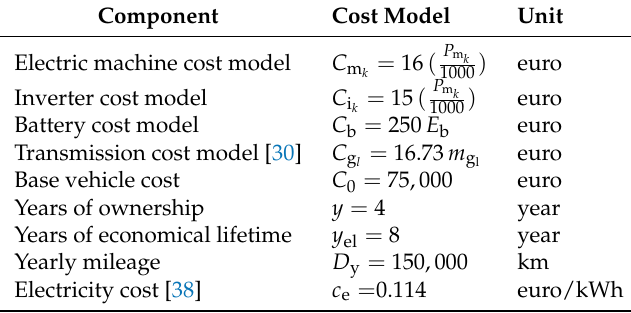
Table 5. Cost models of powertrain components and assumed simulation input parameters.